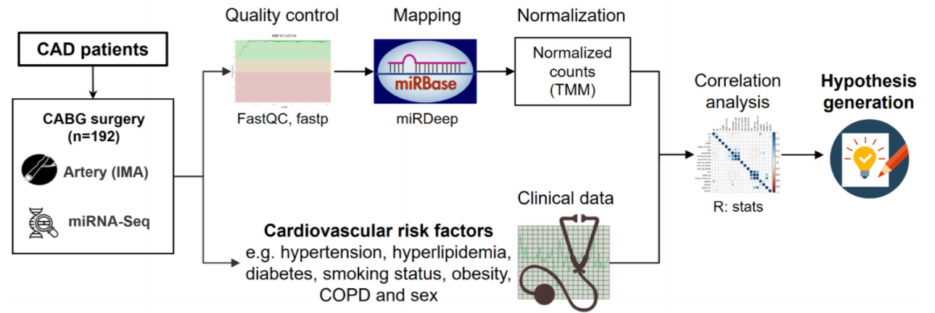
Figure 1. Provided is the workflow of the study including study cohort, miR sequencing, bio-